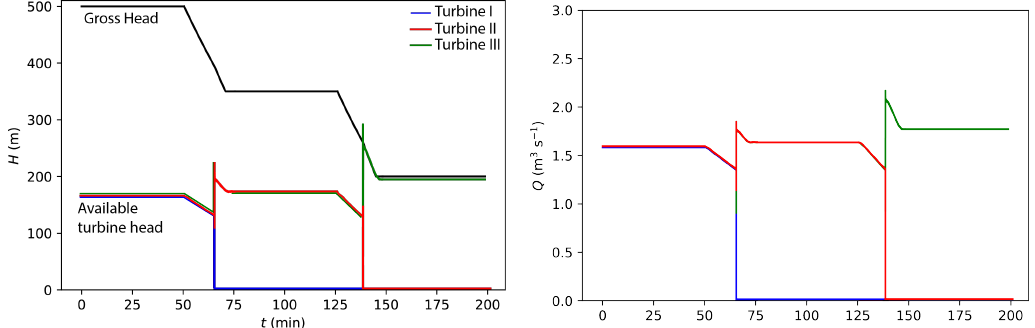
Figure 11. Operating sequence of the three Francis turbines in series to cope with 300 m gross head variation of the power plant.